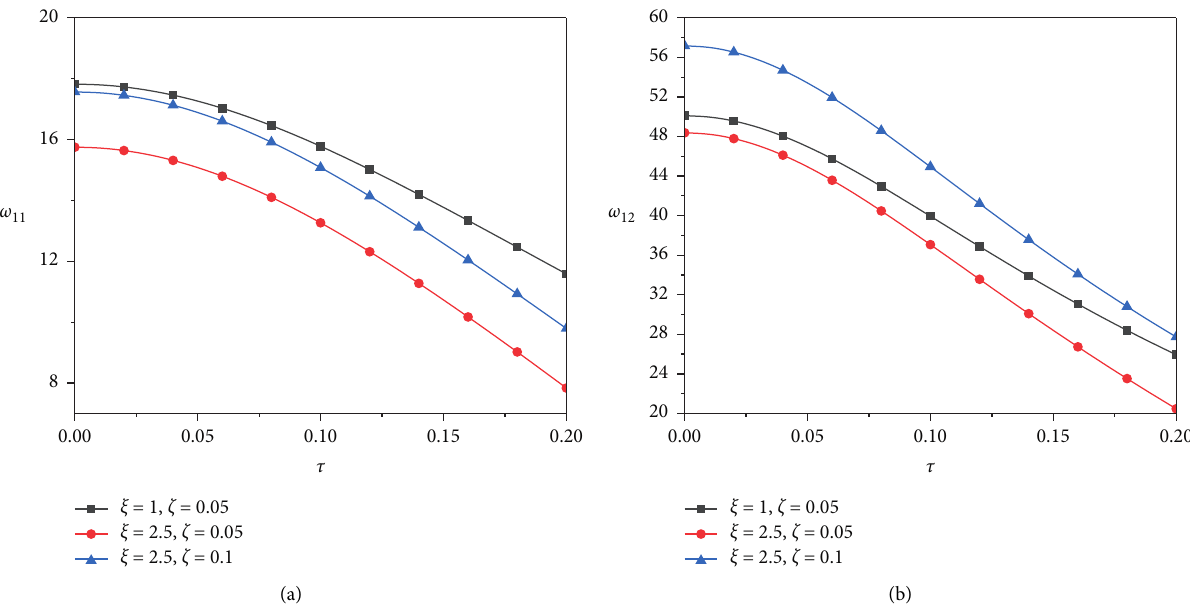
Figure 8: Effect of the nonlocal parameter on the vibration frequency of the functionally graded nanoplate: (a) the first-order vibration frequency and (b) the second-order vibration frequency.